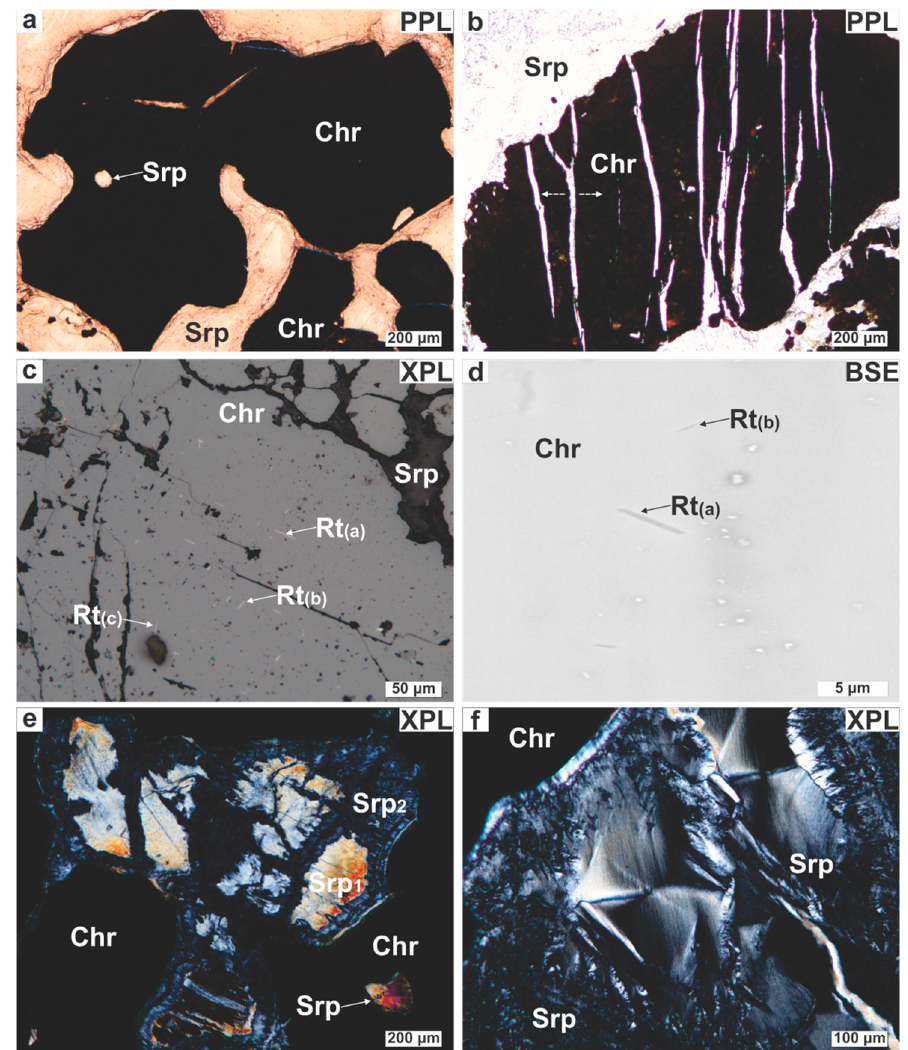
Figure 4. Photomicrographs illustrating the petrographic characteristics of the Ayios Stefanos chromitites. ( a ) Reddish lobate Cr-spinel; ( b ) Chromian spinel displaying pull-apart-like texture (marked by the white arrows); ( c , d ) Rutile exsolutions developed in three crystallographic orientations [Rt (a) , Rt (b) , Rt (c) ]; ( e ) Bastite cut by late serpentine veins; ( f ) Serpentine showing hourglass texture. Abbreviations (in order of appearance): Chr = Cr-spinel; Srp = serpentine; Rt = rutile; Srp 1 = early serpentine; Srp 2 = late serpentine; PPL = plane polarized light; XPL = crossed polarized light; BSE = back scattered electron (image).